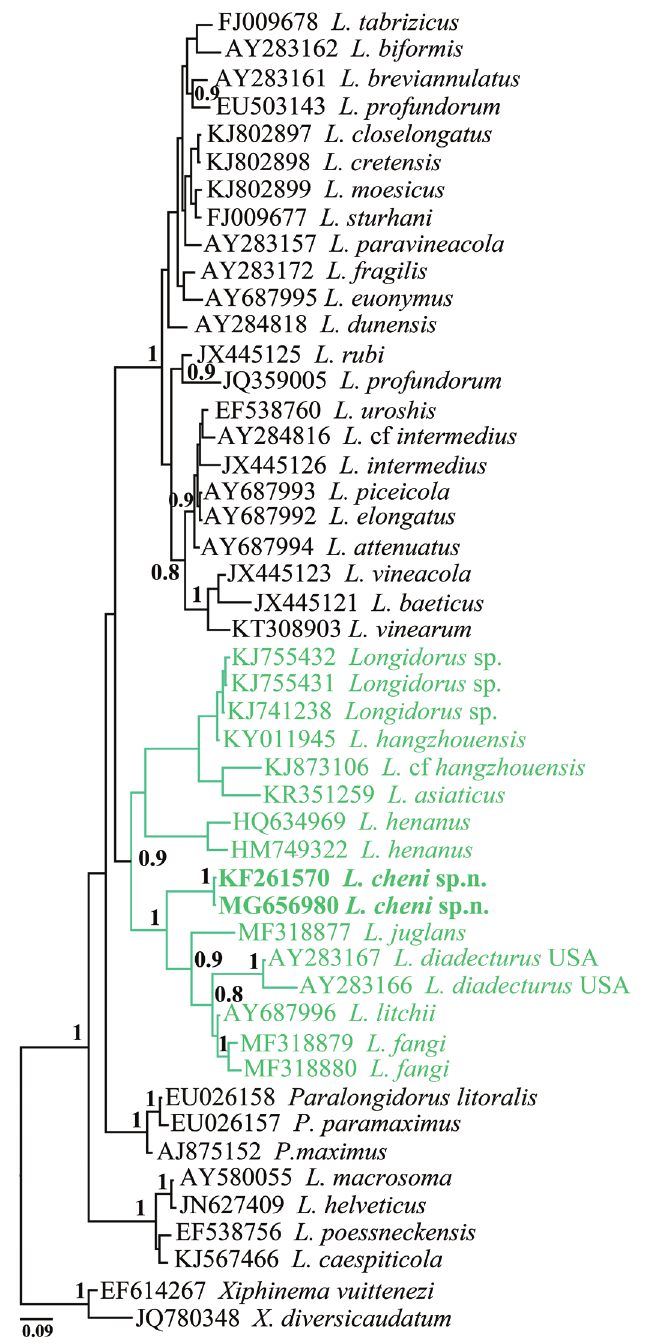
Figure 6. Phylogenetic tree using 18S rDNA and inferred from a Bayesian analysis with GTR+G model and Xiphinema spp. as an outgroup. Posterior probabilities ≥ than 0.8 are